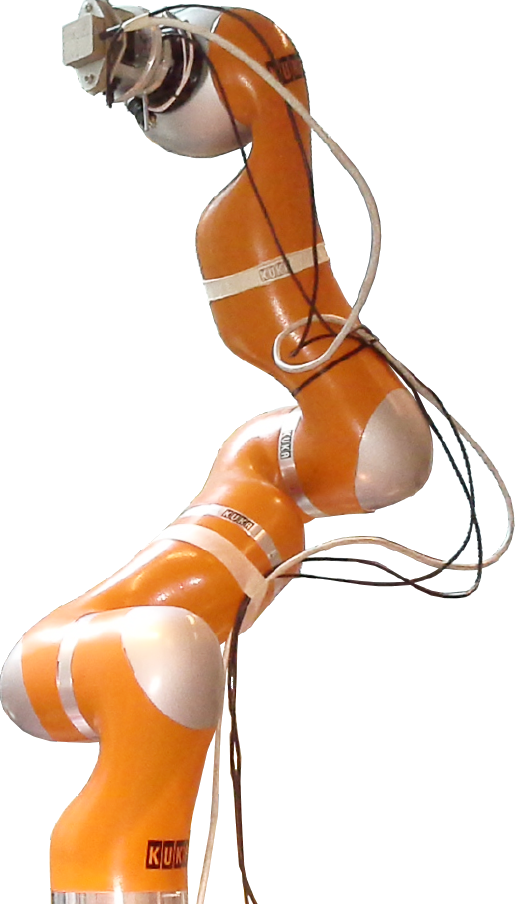
Figure 8: A high-cost 7 degrees of freedom KUKA Lightweight Robot 4+ used to actuate low-cost IMUs mounted on top and to collect a reference